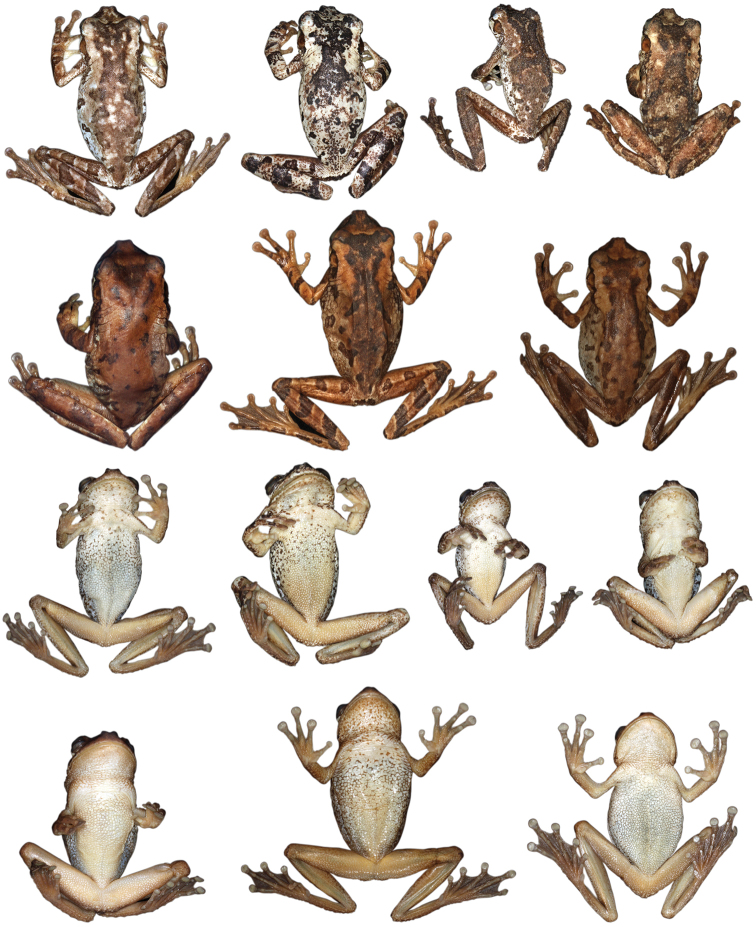
Adult Osteocephalus germani showing variation in dorsal and ventral coloration of preserved specimens. Left to right, upper row: CORBIDI 08267 (female), 05505 (female), 05462 (male, holotype), 06660 (male), CORBIDI 06663 (female), 08284 (female), 08059 (female); third and fourth rows show ventral views of the same specimens, in the same order as in the first two rows. Peru, Region Cusco.